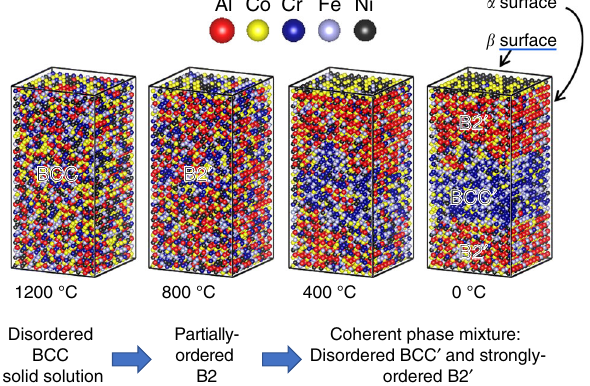
Fig. 1 Monte Carlo simulations of a two-step cooling transformation in the AlCoCrFeNi HEA. The atomic distributions for a series of different temperatures are illustrated, using supercells, composed of 12 × 12 × 24 cubic unit cells, where each unit cell contains one α and one β site. The supercells are “ cut ” to highlight con fi gurational ordering, such that the side surfaces contain Al-rich α sites, and the top surface contains Al-poor β sites. Based upon the element-speci fi c long-range order parameters (Fig. 3c), we fi nd that the high-temperature phase is a disordered solid solution, which transitions to a partially ordered phase during cooling to 800 °C. Upon further cooling, the partially ordered phase transforms into a mixture of disordered Cr-Fe-enriched BCC and strongly ordered Al-Co-Ni- enriched B2